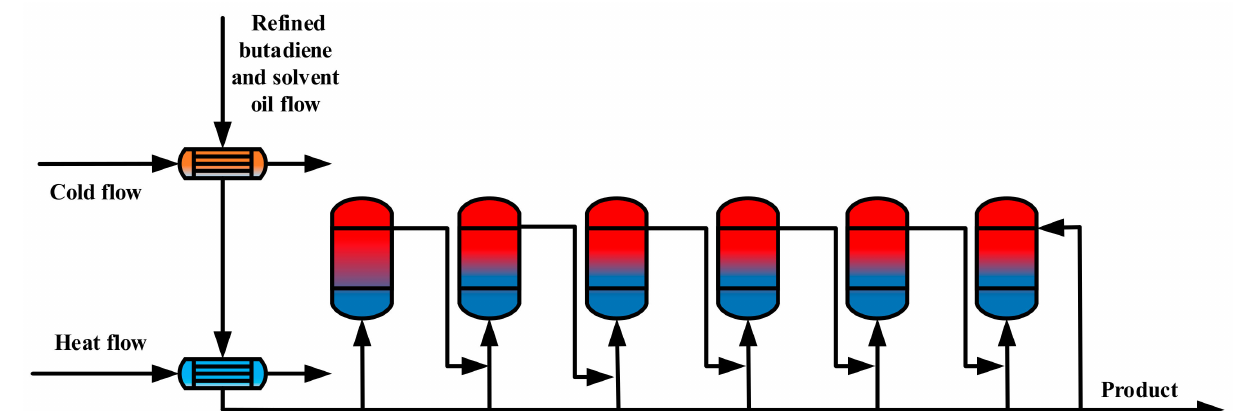
Figure 1. The schematic diagram of the polymerization